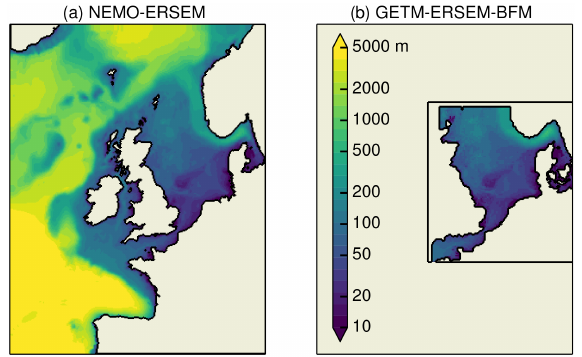
Figure 1. Maps of the model domain and bathymetry for (a) NEMO-ERSEM and (b)